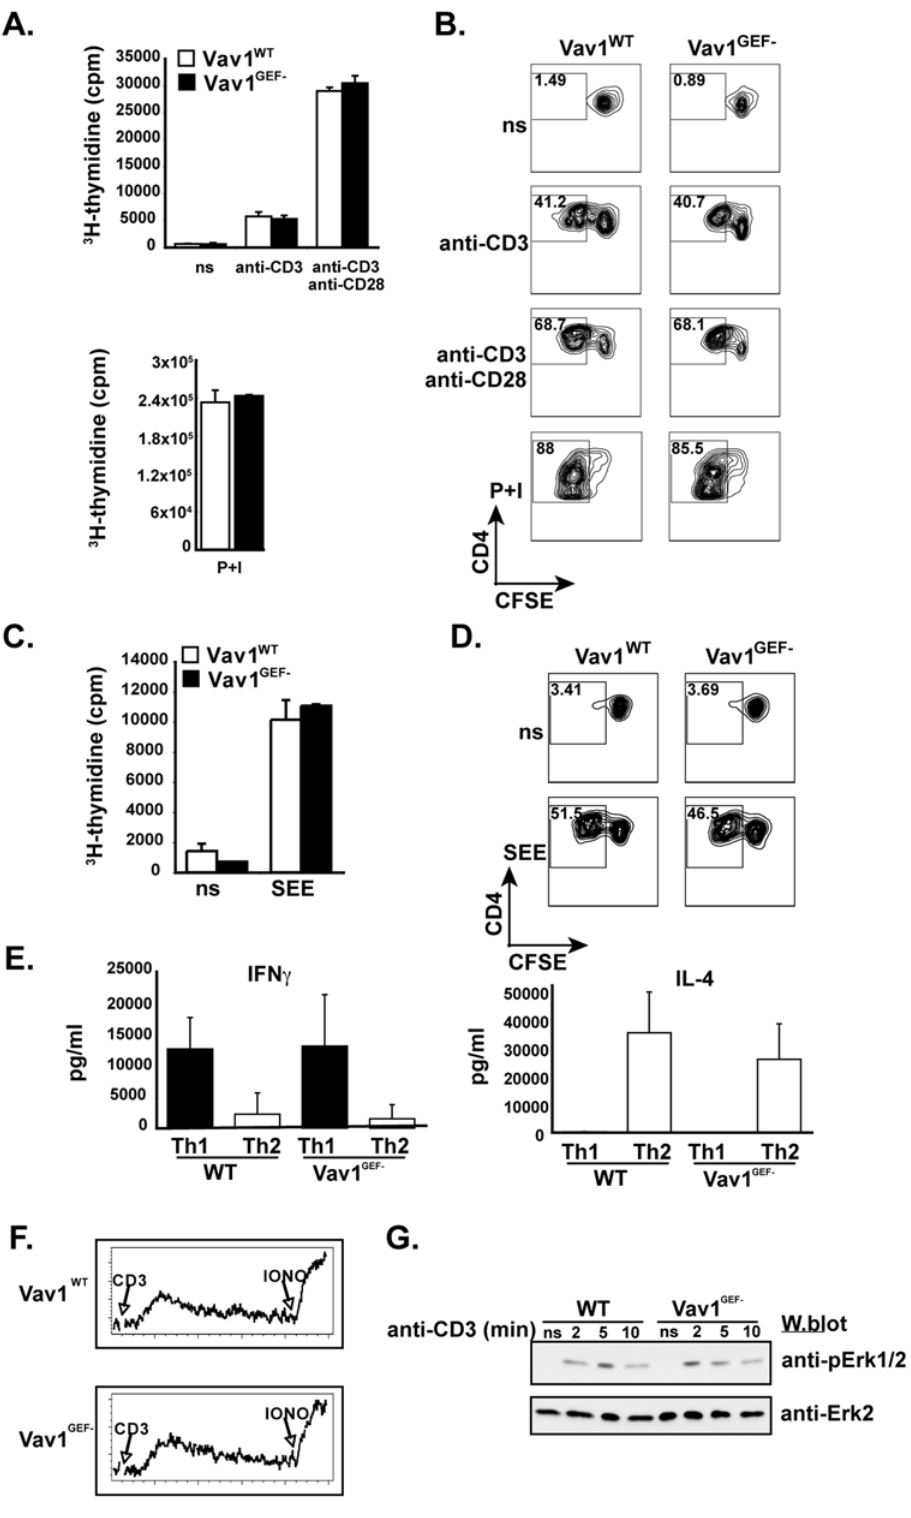
Figure 5. Vav1 GEF activity is not required for T cell function. (A) Proliferation of Vav1 WT or Vav1 GEF 2 T cells stimulated with anti-CD3 + / 2 anti-CD28 antibodies, measured by 3 H-thymidine incorporation at 48 hours, n . 3. P + I=PMA and ionomycin. (B) As in (A), with CFSE dye dilution at 72 hours, n . 3. (C) Proliferation of Vav1 WT or Vav1 GEF 2 T cells stimulated with SEE-pulsed APCs, measured by 3 H-thymidine incorporation at 48 hours, n . 3. (D) As in (C), with CFSE dye dilution at 72 hours, n . 3. (E) Supernatant cytokines from T cells cultured under Th1 or Th2 polarizing conditions were analyzed by ELISA, n . 4. (F) Ca ++ mobilization by CD4 + T cells stimulated with anti-CD3 antibodies, n=5. (G) Erk1/2 activation in T cells activated with anti-CD3 antibodies for indicated time points, visualized by immunoblotting with antibodies against active Erk1/2. Protein loading was verified by reprobing blots with anti-Erk2 antibodies.